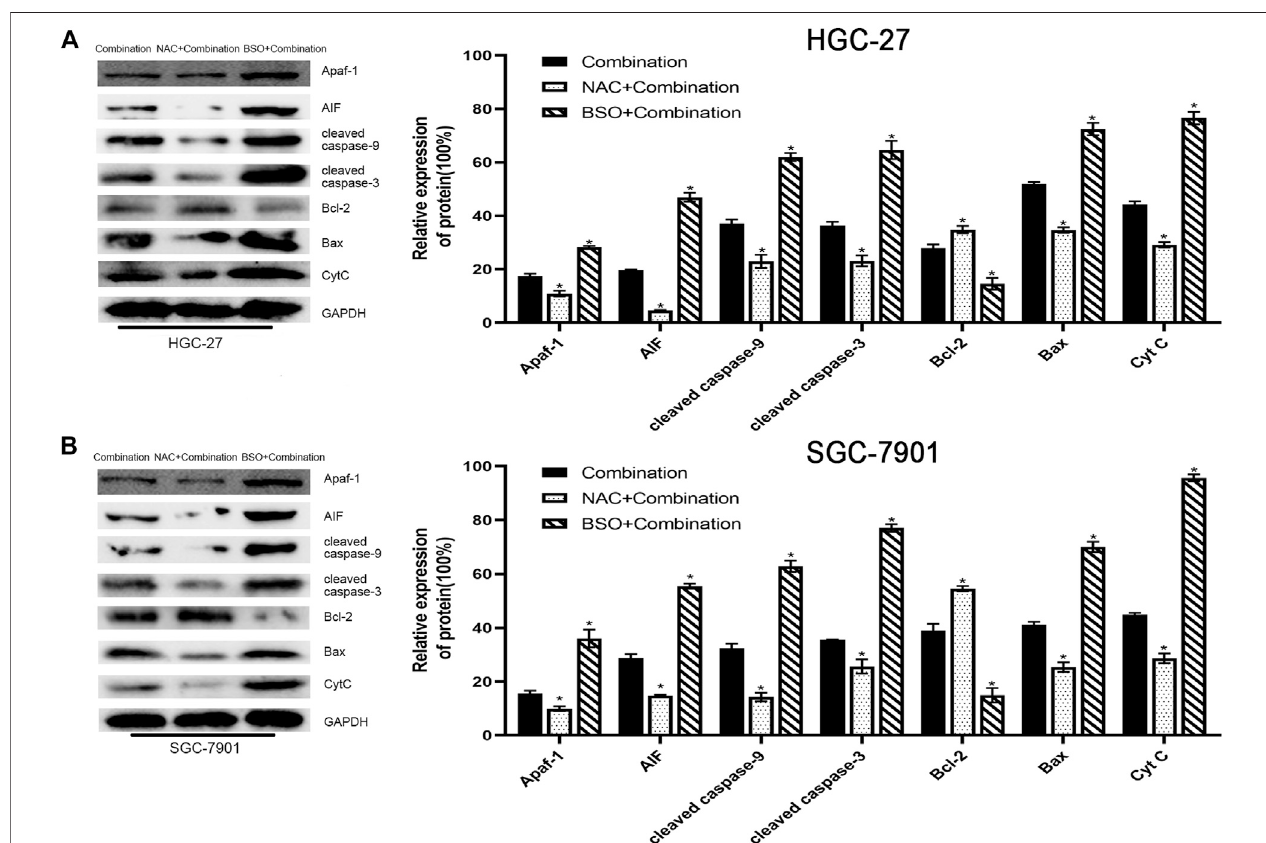
FIGURE7| PretreatmentwithNACorBSO,respectively,decreasedorincreasedthelevelsofmitochondrialapoptosispathway-relatedproteins. (A) HGC-27cells were treated with 4 µg/ml cisplatin +10 mM sodium butyrate, NAC pretreatment + combination, or BSO pretreatment + combination and western blotting was performed to detect the levels of related proteins. * p < 0.05 vs the combination group. (B) SGC-7901 cells were treated with 4 µg/ml cisplatin +5 mM sodium butyrate, NACpretreatment+combination,orBSOpretreatment+combinationandwesternblottingwasperformedtodetectthelevelsofrelatedproteins.* p < 0.05vsthe combination group. All the above data are the mean ± SD from an average of three